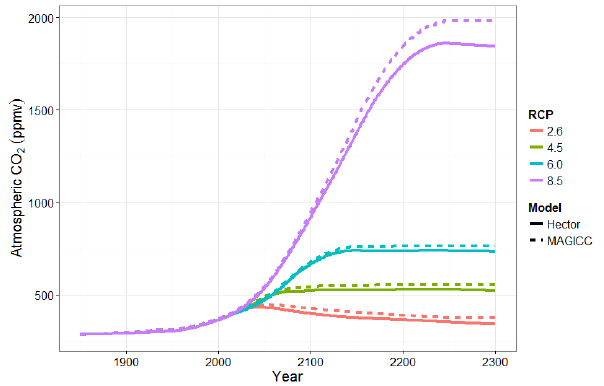
Figure 6. Atmospheric [CO 2 ] from 1850 to 2300 for RCP 2.6 (red), RCP 4.5 (green), RCP 6.0 (blue), RCP 8.5 (purple), Hector (solid) and MAGICC6 (dashed).